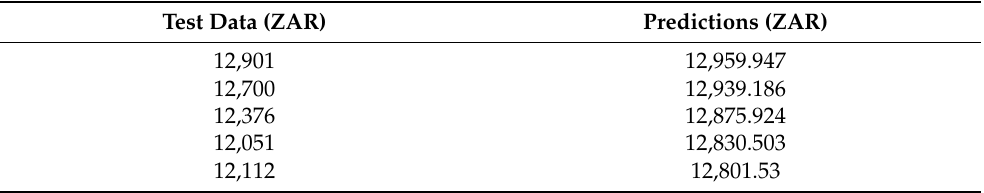
Table 7. Experiment 2.3